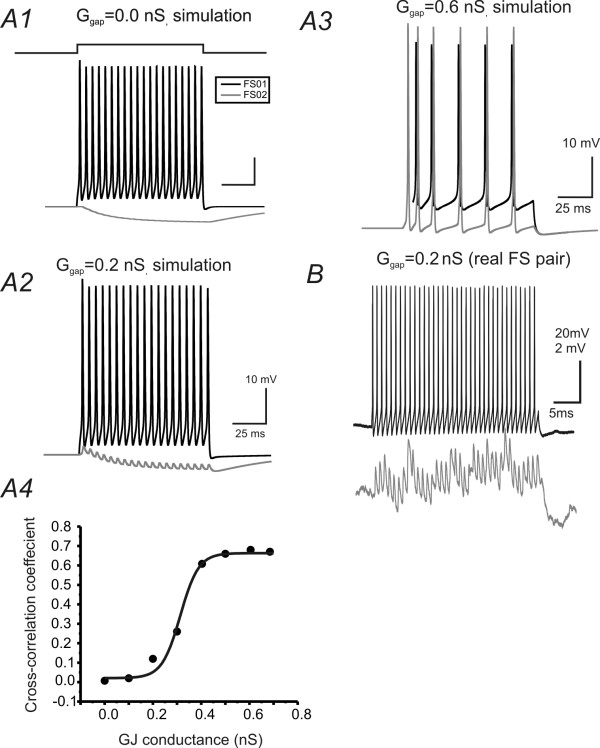
Roles of GJs in synchronizing DC- induced spikes in simulated networks. A1) Current (200 pA) injection in one of the GJ coupled cells (black trace) induced direct (black) and coupled (gray) responses in both cells. Cells in A1, A2 & A3 have a EPJP strength of 0 (A1), 0.2(A2) & 0.6 (A2), respectively. A4) Cross-correlation coefficient plotted against strength of EPJP conductance in the simulation (n = 10 trials). Solid line: data fitted with a Bolztmann equation. B) Recordings were made from a GJ coupled FS pair (EPJP conductance of 0.2 nS) in a brain slice.